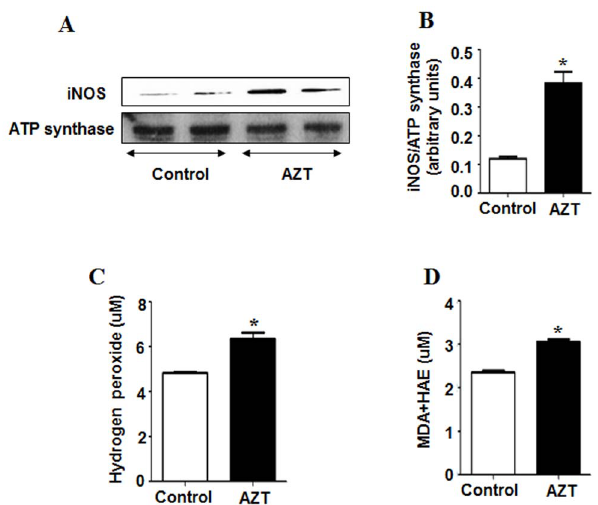
Figure 3. AZT-mediated increments of oxidative stress mark- ers. (A) Equal amounts of mitochondrial proteins (50 m g/lane) were used to evaluate the levels of mitochondrial iNOS (upper panel) and ATP synthase (lower panel) from both groups. (B) The densities of iNOS bands were normalized to that of ATP synthase, the loading control. (C) The rate of production of hydrogen peroxide and (D) the level of MDA + HAE as a marker of lipid peroxidation was measured as described in the Materials and Methods. *Significantly different from the control group. Data indicate mean 6 SE, p , 0.05. All experiments have been conducted three